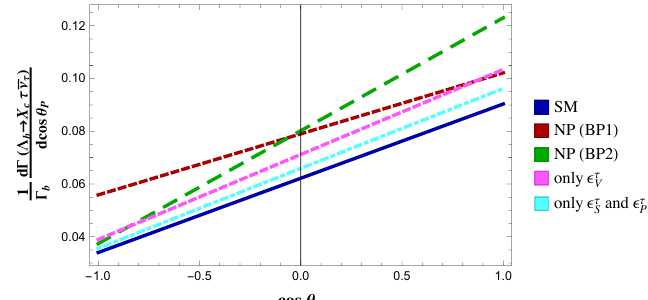
d (cid:0) Figure 6 . 1 distribution for (cid:3) b ! X c (cid:28) (cid:22) (cid:23) (cid:28) in SM and in NP scenarios with di(cid:11)erent values (cid:0) b d cos (cid:18) P of the e(cid:11)ective couplings. The line NP(BP1) corresponds to (cid:15) (cid:28) NP(BP2), \only (cid:15) (cid:28) " and \only (cid:15) (cid:28) and (cid:15) (cid:28) " correspond to the values of the couplings (cid:12)xed in ref. [59], V S P see the